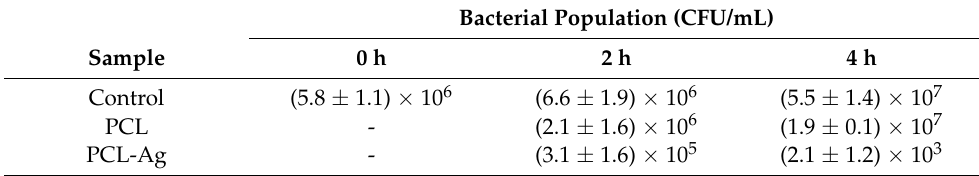
Figure 7. Photographs of Petri dishes obtained from E. coli culture without any mat (Control) and cultures with blank PCL and PCL-Ag mats at different serial dilutions from 10 − 1 to 10 − 4 (writing on the covers) and different sampled times (0, 2 and 4 h). Top right panel: graph of data obtained from the CFU calculations. Table 3. Bacterial population (CFU/mL) measured for control, uncoated sample (PCL) and coated sample (PCL-Ag) at different times. Data are reported as mean ± standard deviations from two independent experiments, each in triplicate.